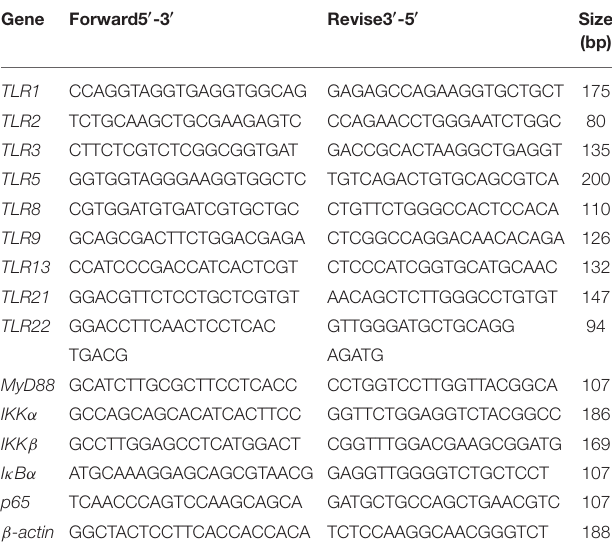
TABLE 3 | Primers used for real-time quantitative PCR analysis. Gene Forward5 ′ -3 ′